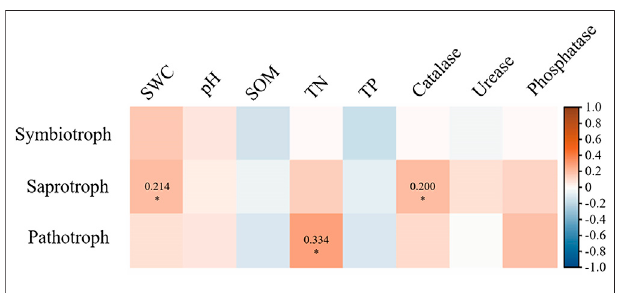
FIGURE 5 | Correlation between soil fungal functional group and soil properties. The color represents Mantel ’ r value. The * indicates signi fi cant correlation, and the Mantel ’ r values of signi fi cant correlation were